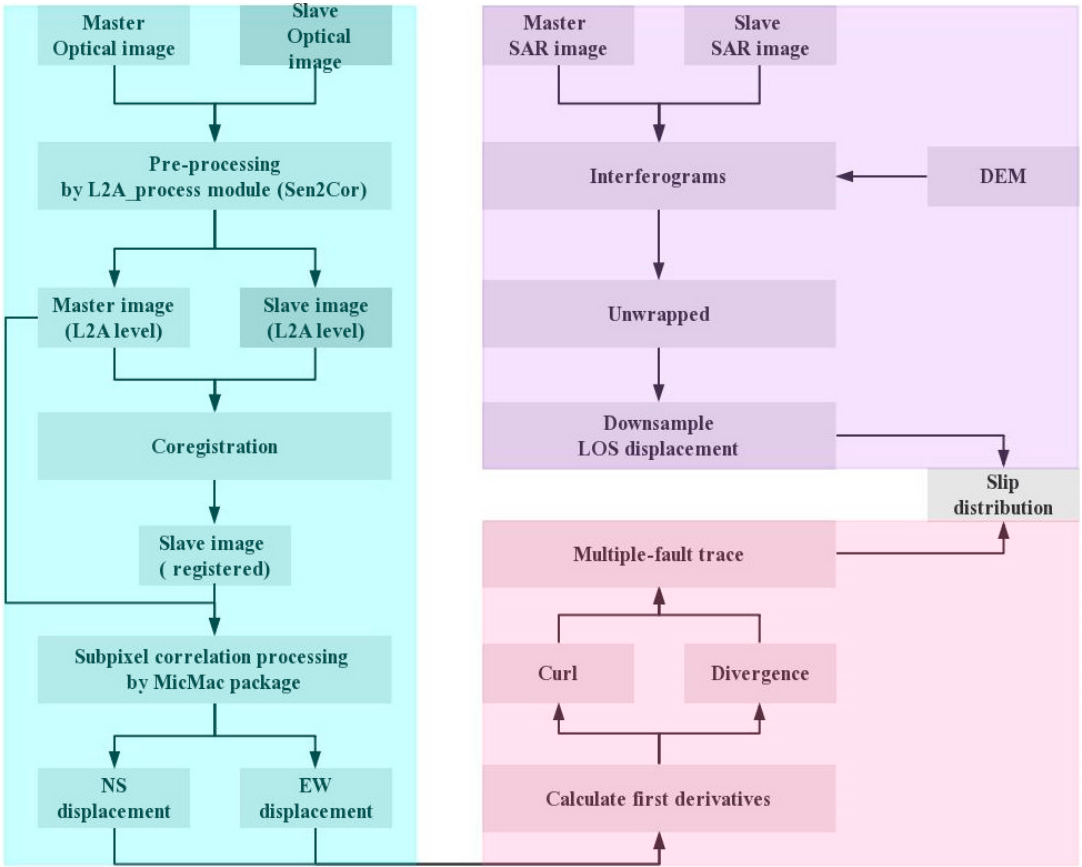
Figure 2. Overview of the data processing chain used in this investigation. Sen2Cor is a processor for Sentinel-2 Level 2A (L2A level) product generation and formatting. MicMac: Multi Images Correspondances par Méthodes Automatiques de Corrélation. LOS: line-of-sight. DEM: digital elevation model.